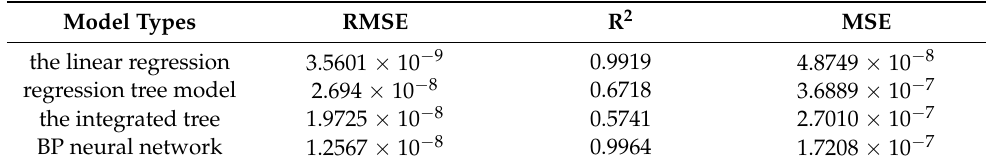
Figure 5. Residual of each training model: ( a ) Linear regression model; ( b ) Regression tree model; ( c ) Integration Tree Model; ( d ) BP neural network model. Table 5. Measuring point 1 ( z -axis) regression model evaluation